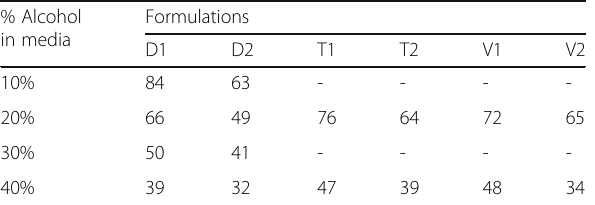
Table 6 f 2 values for diclofenac (D), tramadol (T) and venlafaxine (V) formulations in the presence of alcohol (data from reference (Avachat & Nandare